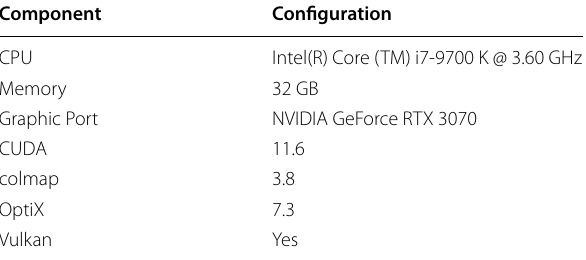
Table 4 Run configuration of reconstruction